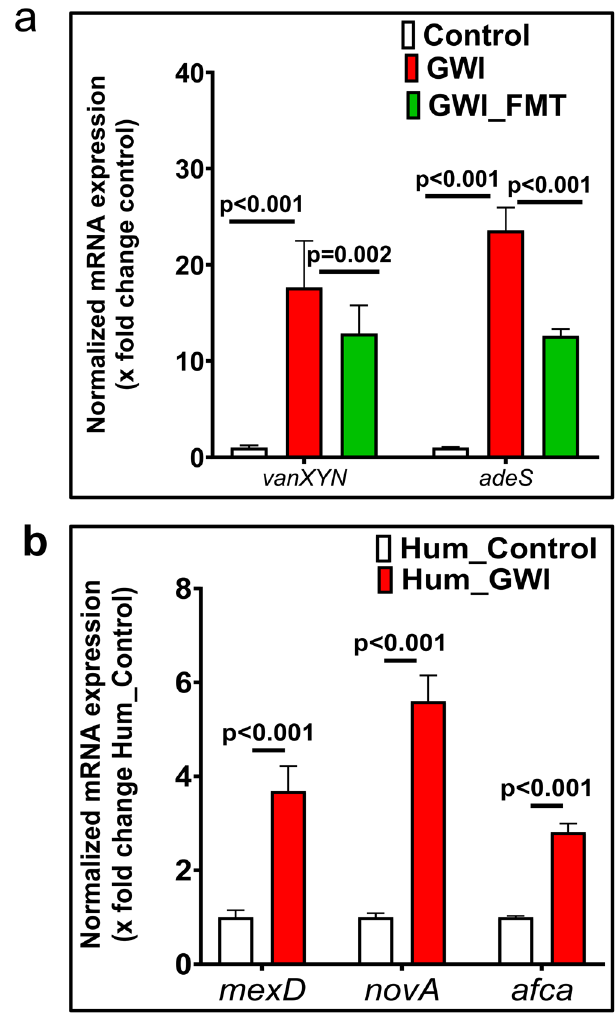
Fig. 5 Relative expression levels of antimicrobial resistance genes. Relative mRNA expression of ARGs. a Between mouse experimental groups Control ( n = 11 biologically independent samples), GWI ( n = 11 biologically independent samples) and GWI_FMT ( n = 6 biologically independent samples). b Between GW Veteran groups Hum_Control ( n = 5 biologically independent samples) and Hum_GWI ( n = 28 biologically independent samples). The mRNA expression was calculated as fold change against control (in Fig. 6a) and against Hum_Control (in Fig. 6b). Data are represented as mean ± SEM (SEM:Standard Error Mean). p -values were determined using by two-way ANOVA with Bonferroni ’ s post hoc test for GWI mice groups and GW Veteran groups where p < 0.05 was considered statistically signi fi